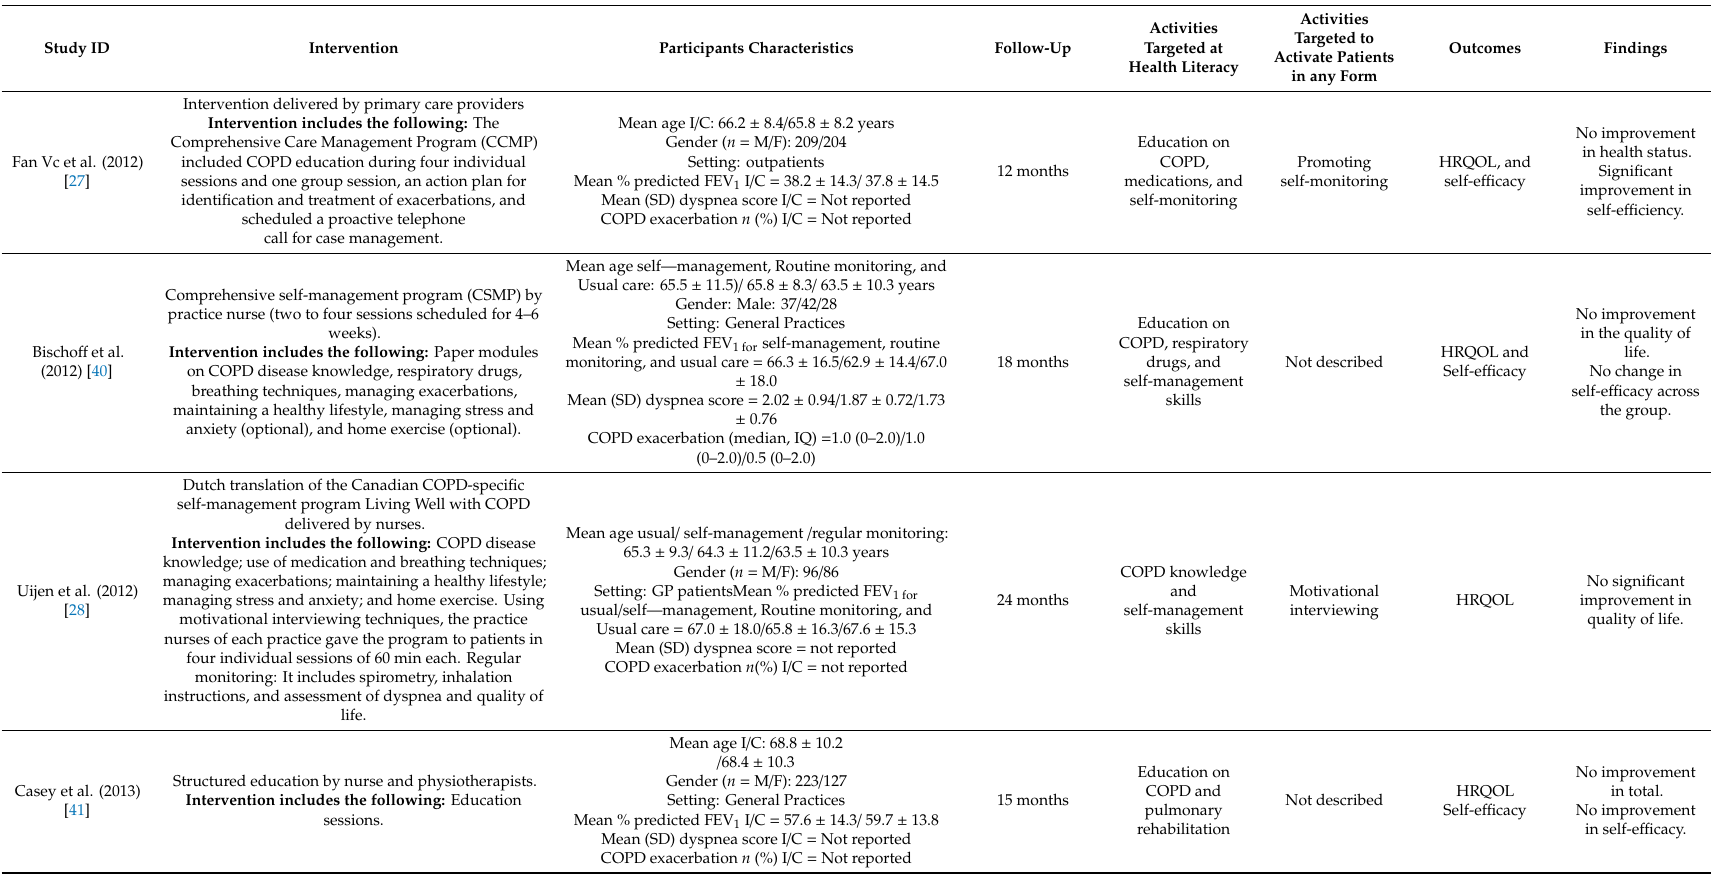
Study ID Intervention Participants Characteristics Follow-Up